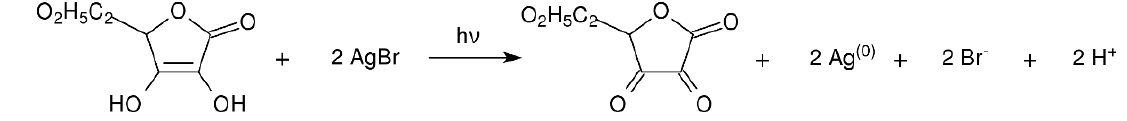
Figure 1. Scheme of reduction of silver bromide with ascorbic